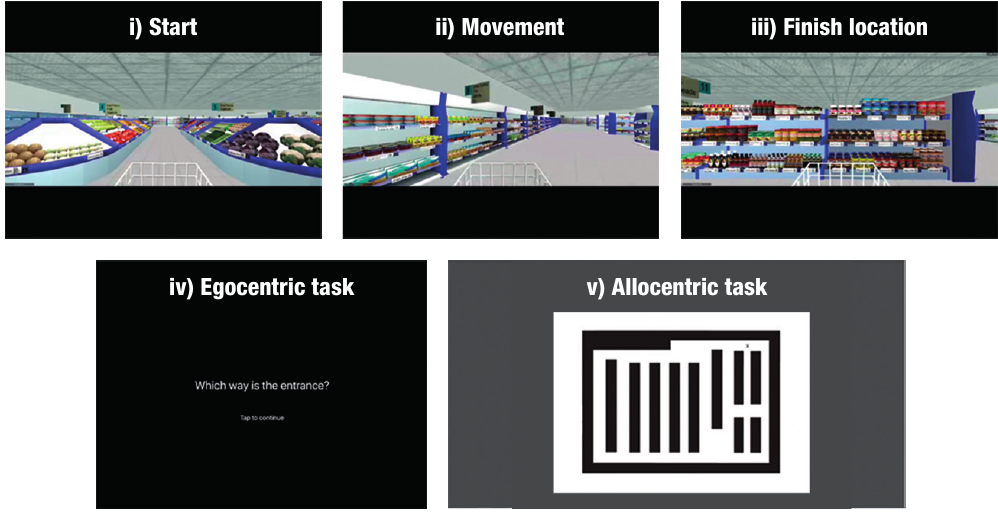
Figure 1. Screenshots from the Supermarket task, showing i) start viewpoint; ii) movement during an example video clip; iii) end location of an example video clip; iv) ‘onscreen instructions prompting the participant to indicate the direction of their starting point’; v) the supermarket map participants use to indicate their finishing location and their heading direction when the video clip